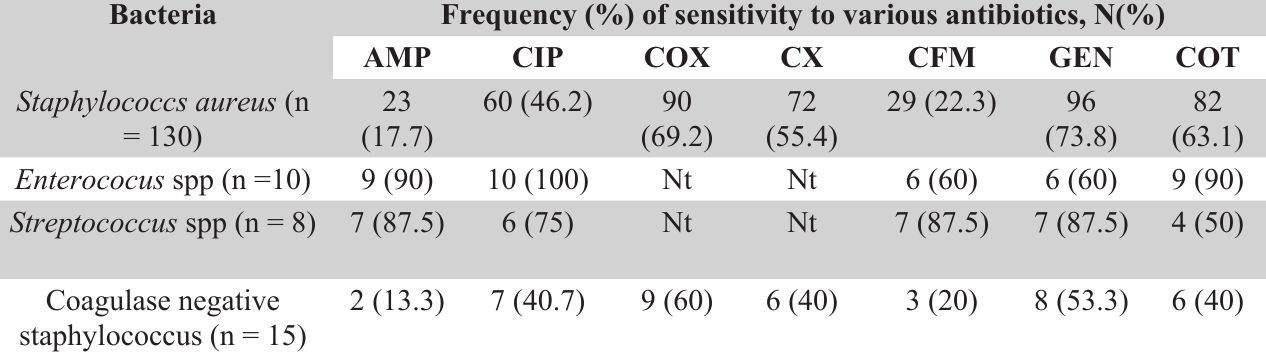
Table 2. Antibiotic sensitivity pattern of gram-positive bacteria. Bacteria